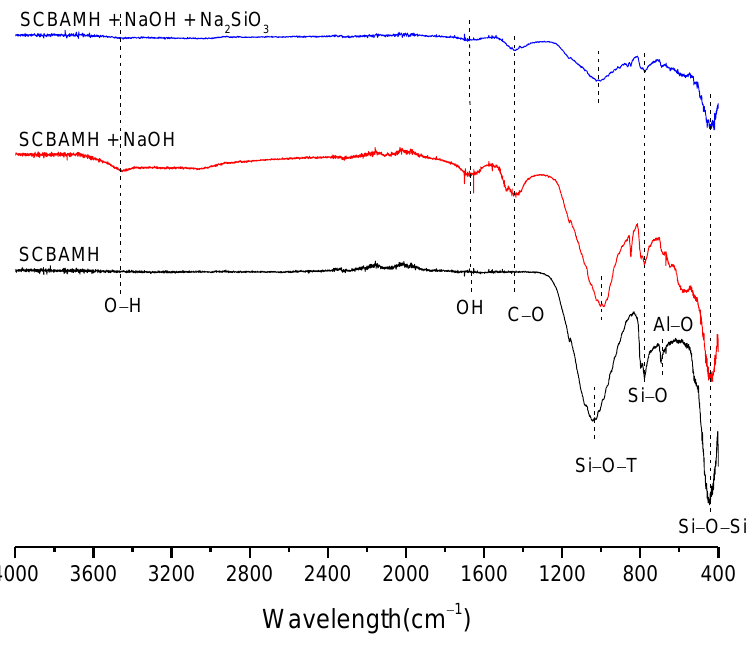
Figure 7. SCBAMH and SCBAMH activated pastes.